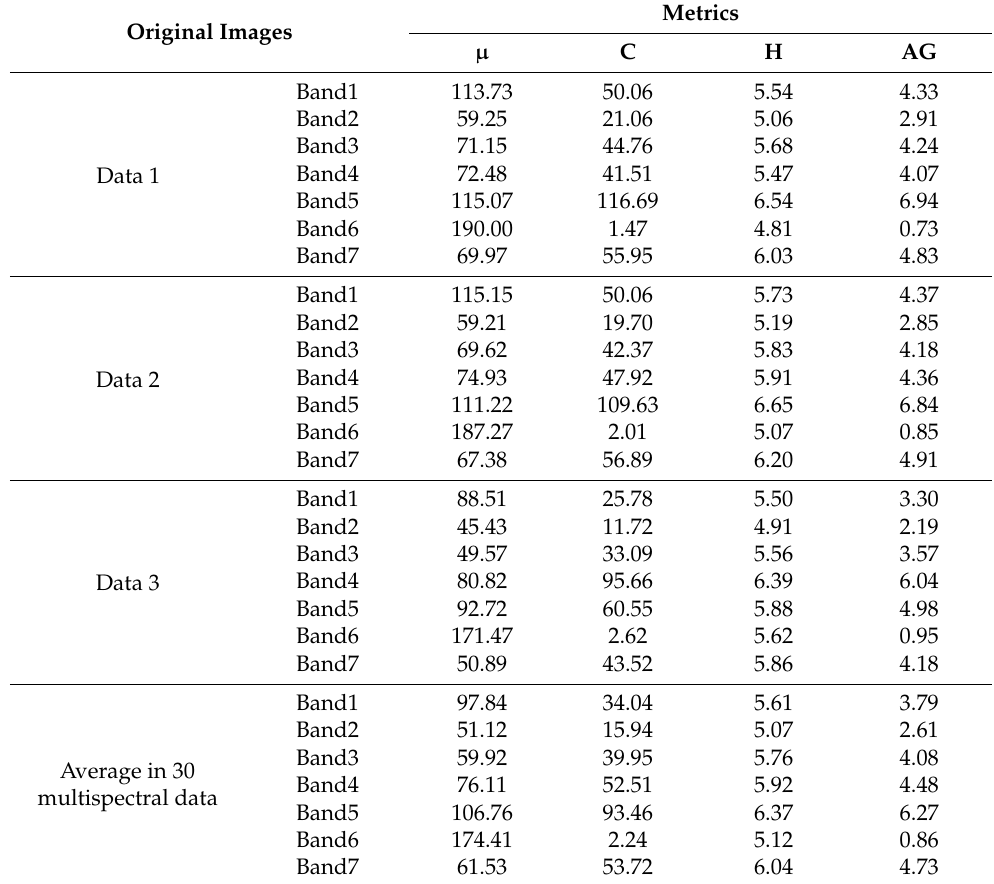
Table 5. The quantitative results of the original multispectral